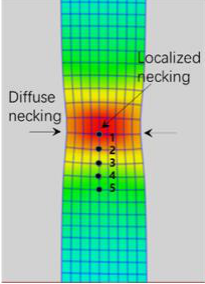
Figure 4. Illustration of selected material points for high-strength steel.